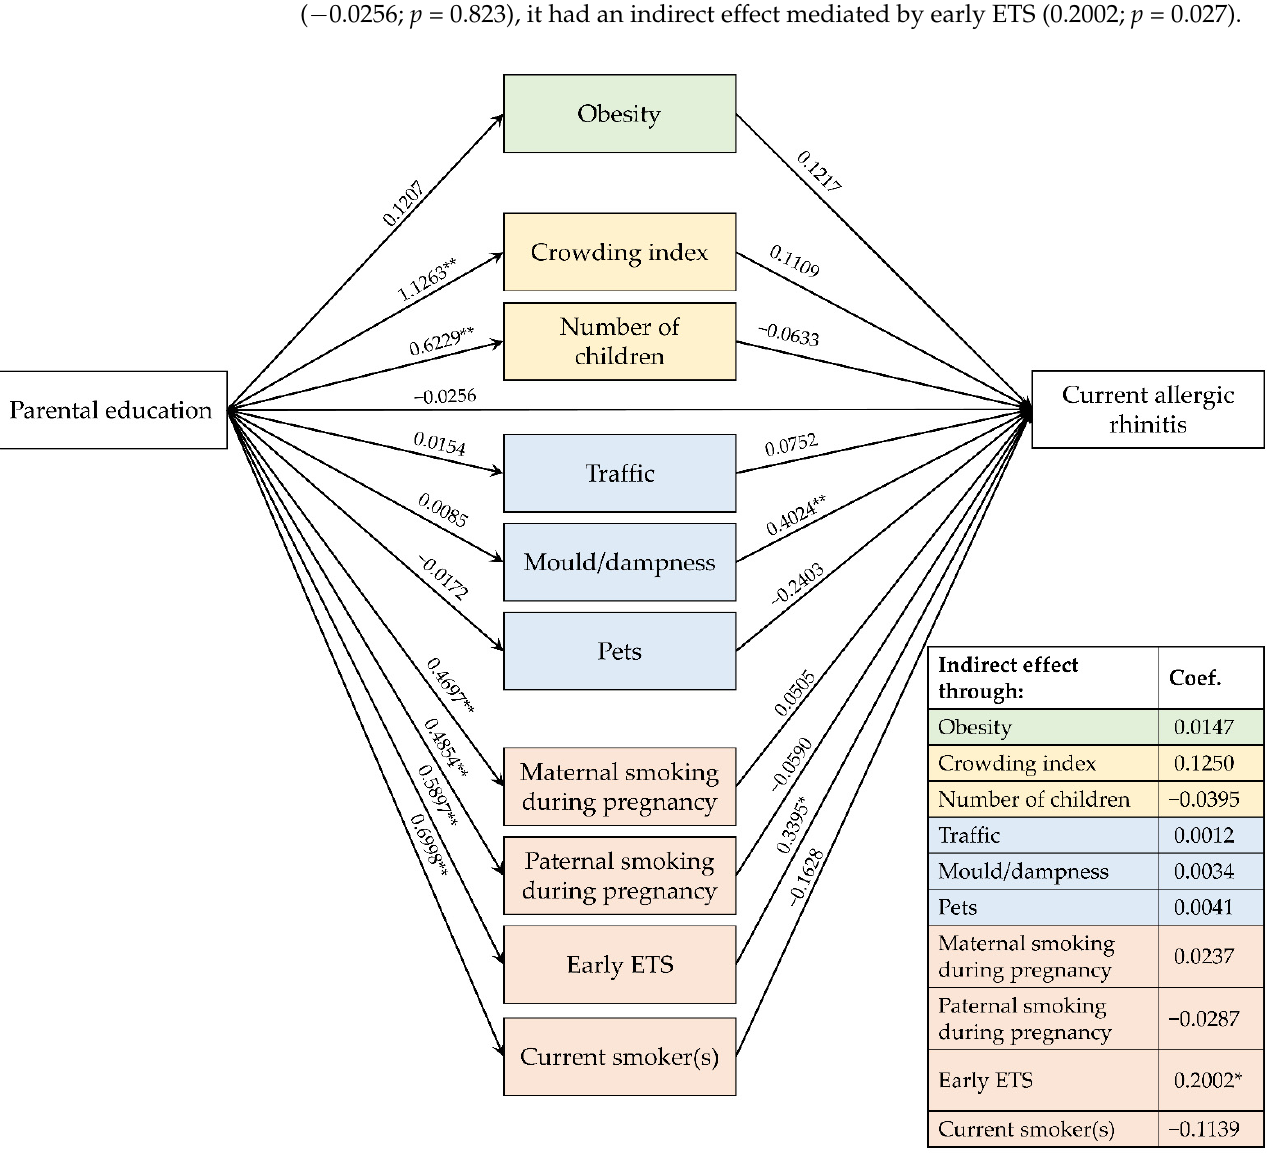
Figure 5. Path diagram of the relationships between parental education, risk factors and current allergic rhinitis. Note. ETS: environmental tobacco smoke; * p < 0.05; ** p < 0.01.